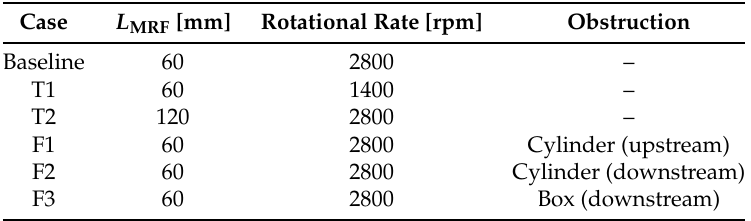
Table 2. Overview of configurations tested in the pipe